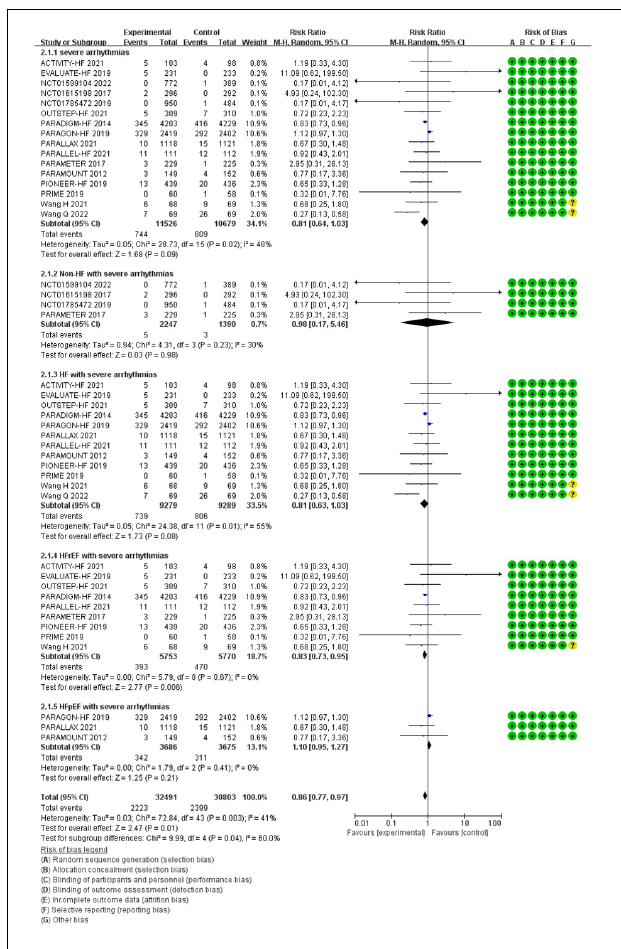
FIGURE 5 | The efficacy of SV compared to ACEI/ARB on severe arrhythmias.